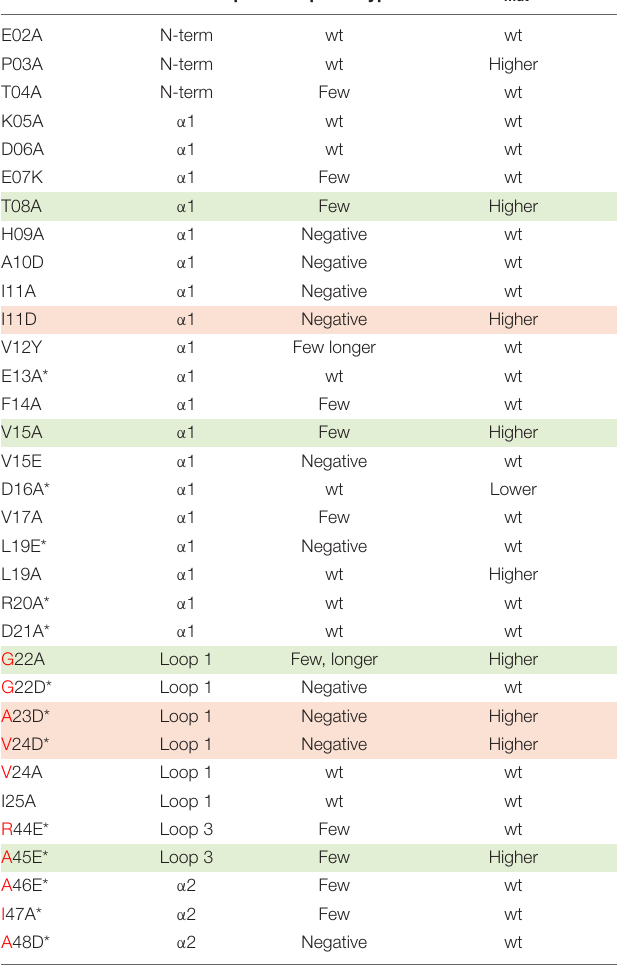
TABLE 1 | Effect of substitutions in GvpM on gas vesicle formation and on the M mut /L interaction.